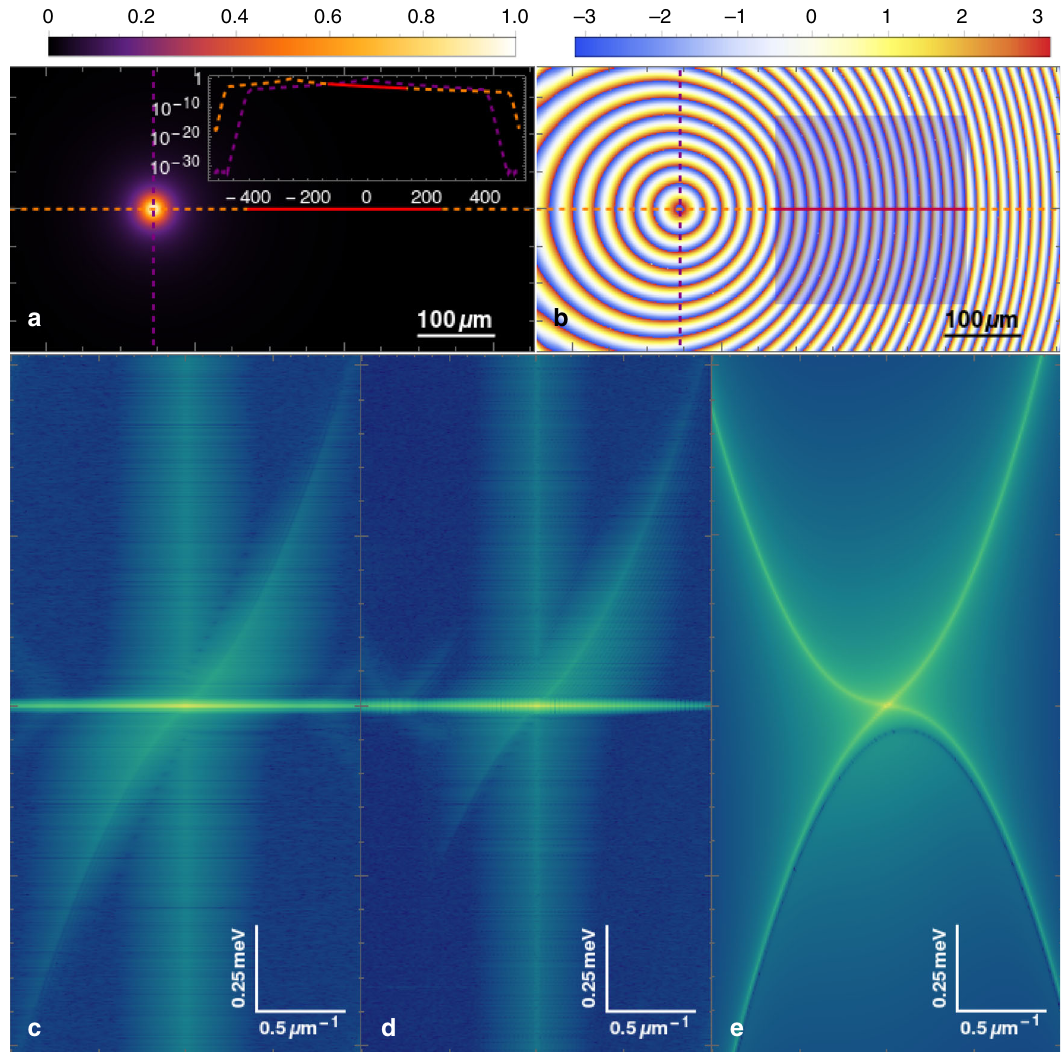
Fig. 5 Numerical and analytical calculations of the spectrum and PL. a Density pro fi le of the condensate under the conditions of Fig. 1 with the pump placed on the left side of the measured region (solid red line in the horizontal pro fi le). The main plot is on a linear scale and the inset a logarithmic one, showing the asymmetric polariton density of the condensate. b Phase (in radians) of the condensate in 2D space. The region under measurement is shown by the semitransparent rectangle. c , d , Excitation spectrum obtained numerically from the FT of g ð 1 Þ ð Δ r ; Δ t Þ , i.e. following the same procedure as in the experiments, and of ψ ð r ; t Þj j 2 , respectively. In the latter case the ghost branch is weakly populated, but still visible. e , PL from analytical calculations in the Bogoliubov approximation under uniform pumping with fi nite condensate velocity. Note that in this case both branches are